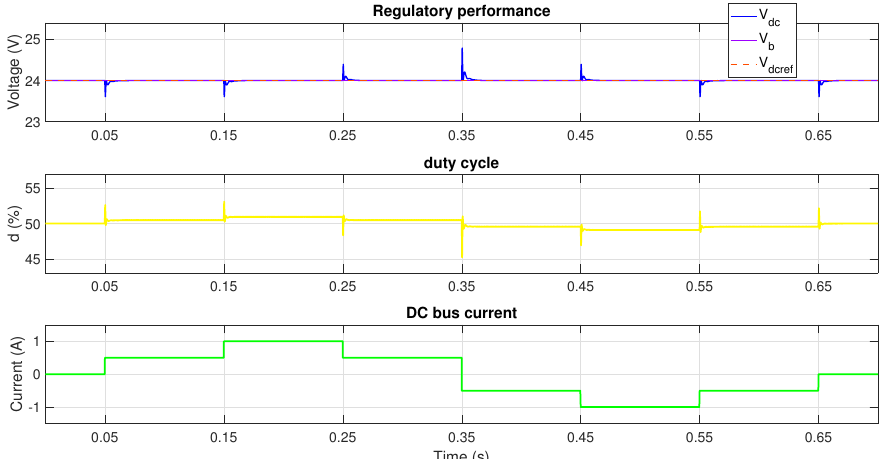
= 24 V (unitary gain ref